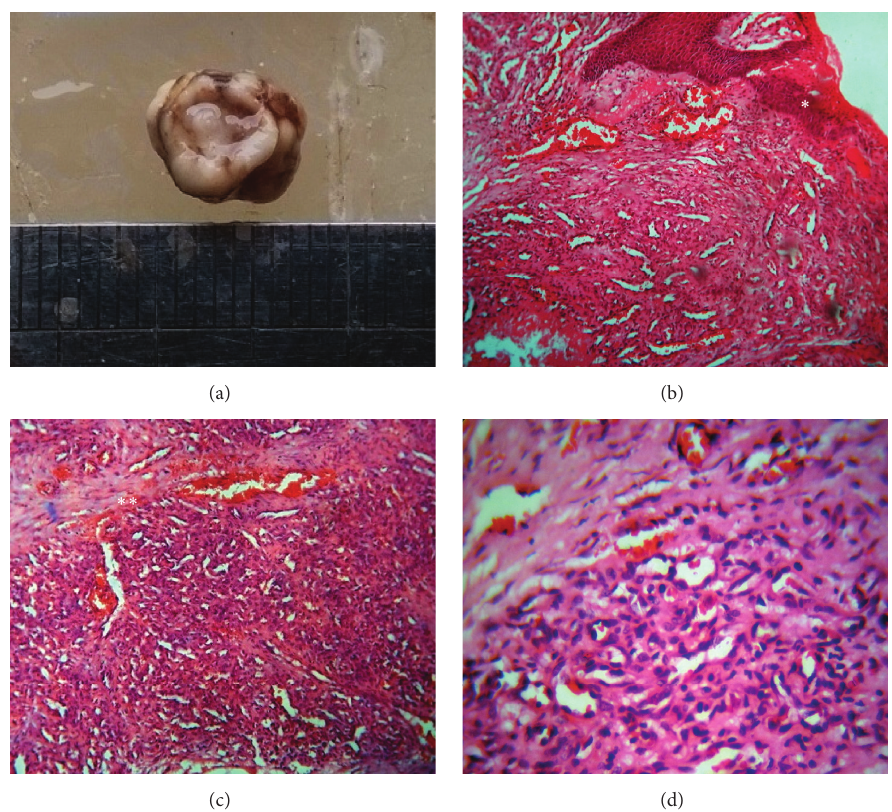
Figure 2: Case 2 description: (a) gross specimen; (b) low power view showing discontinuous parakeratinized stratified squamous epithelium ( ∗ ) with vascular spaces in the underlying stroma (H&E, 100x); (c) low power view showing numerous capillaries arranged within lobulated spaces ( ∗∗ ) (H&E, 100x); (d) high power view showing numerous endothelial cell lined capillaries (H&E,